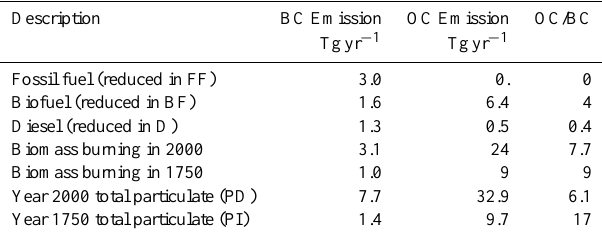
Table 1. Soot emissions (not included are the non-soot emis- sions: sulfur (145TgSy − 1 for 2000 and 34TgSy − 1 for 1750), dust (1680Tgy − 1 ), sea-salt (7900Tgy − 1 ) and 14 Tg OC from nat- ural terpene sources).